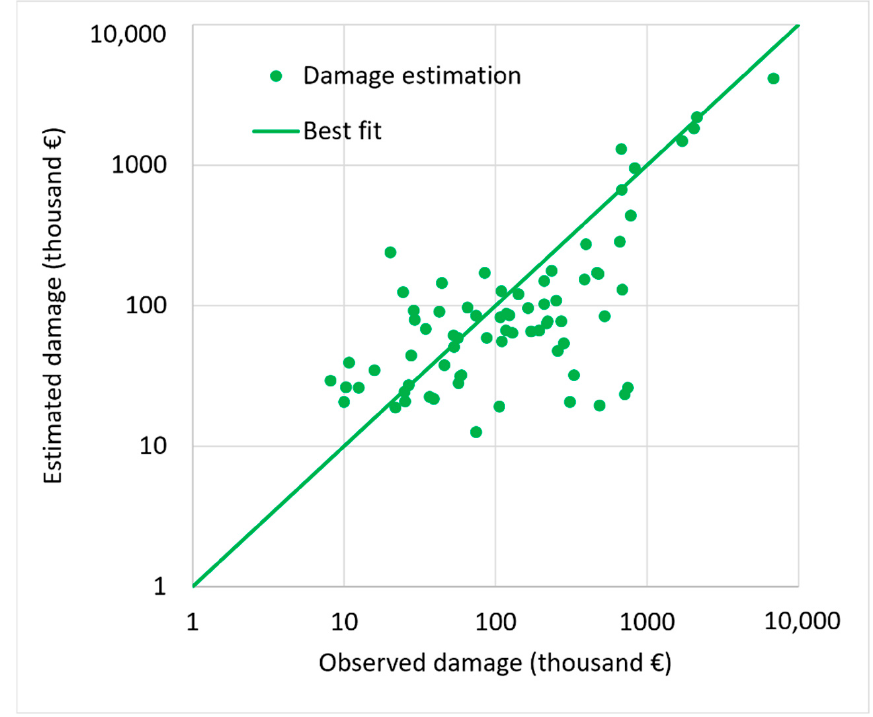
Figure 9. Estimated vs. observed damage for the model validation dataset.